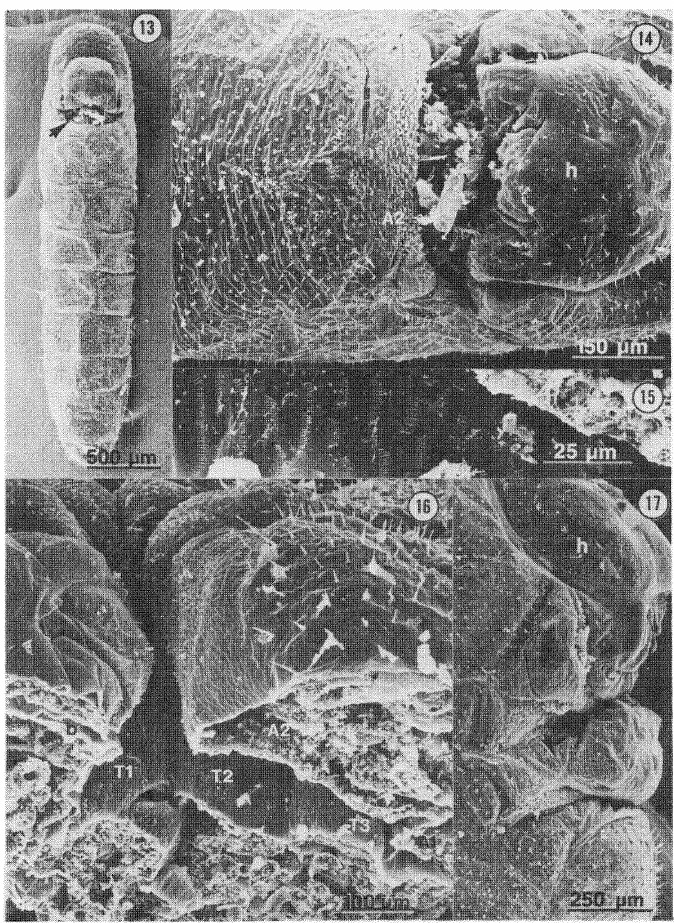
Figs. 13-17. Fig. 13. Ventral view of Pseudomyrmex pallidus showing food in trophothylax (arrow). Fig. 14. High magnification of food in trophothylax of P. pallidus. Note anteriorly pointing spinules on 2nd abdominal segment (A2). Head (h). Fig. 15. Posteriorly pointing metathoracic spinules in trophothylax of Pseudo- myrmex gracilis mexicanus. Fig. 16. Section through trophothylax of P. g. mexica- nus. Note buccal cavity (b), and segments: prothorax (TI); mesothorax (T2); metathorax (T3); 1st abdominal (AI) and 2nd abdominal (A2). Fig. 17. Lateral view of extruded trophothylax of P. g. mexicanus. Note rows of spinules on meta- thorax (arrow). Head